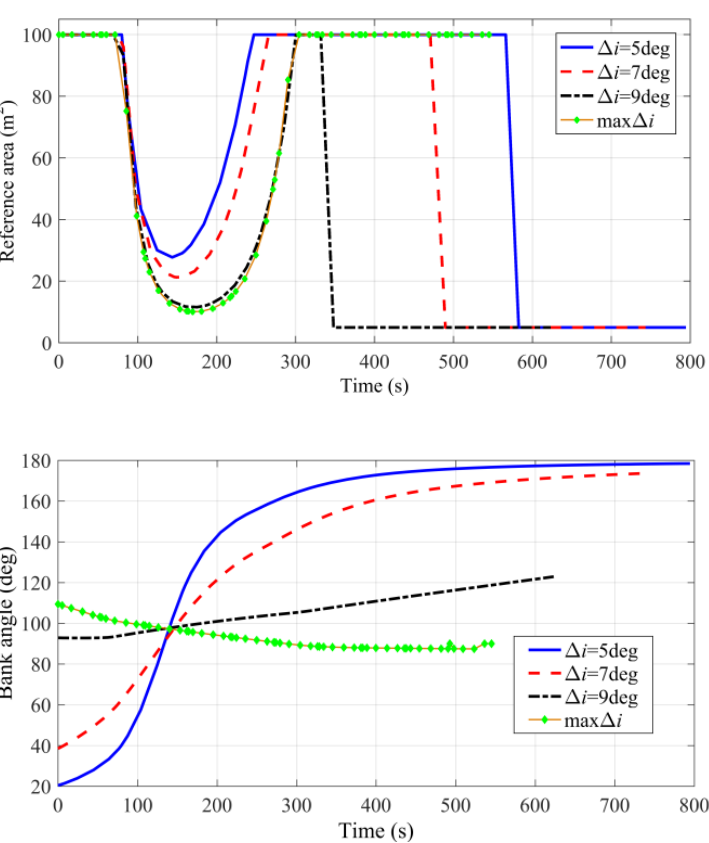
Figure 16. Optimal control variables with different inclination increment constraints.